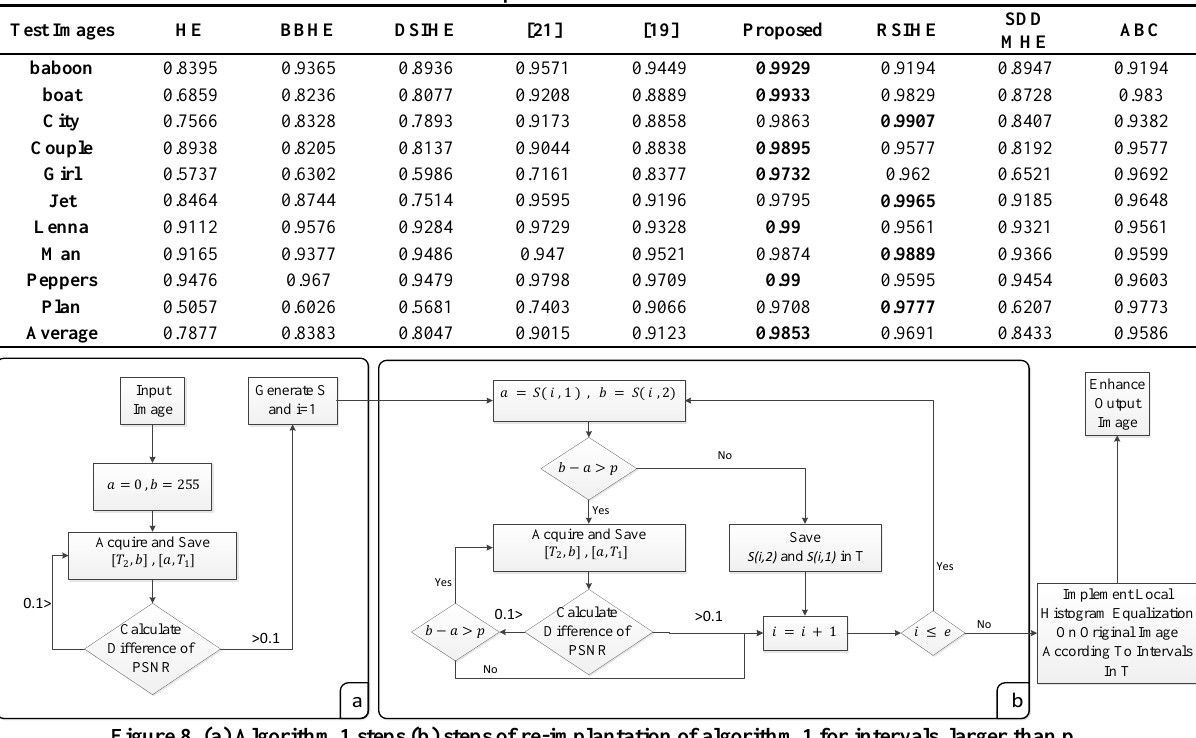
Figure 8. (a) Algorithm 1 steps (b) steps of re-implantation of algorithm 1 for intervals. larger than p.